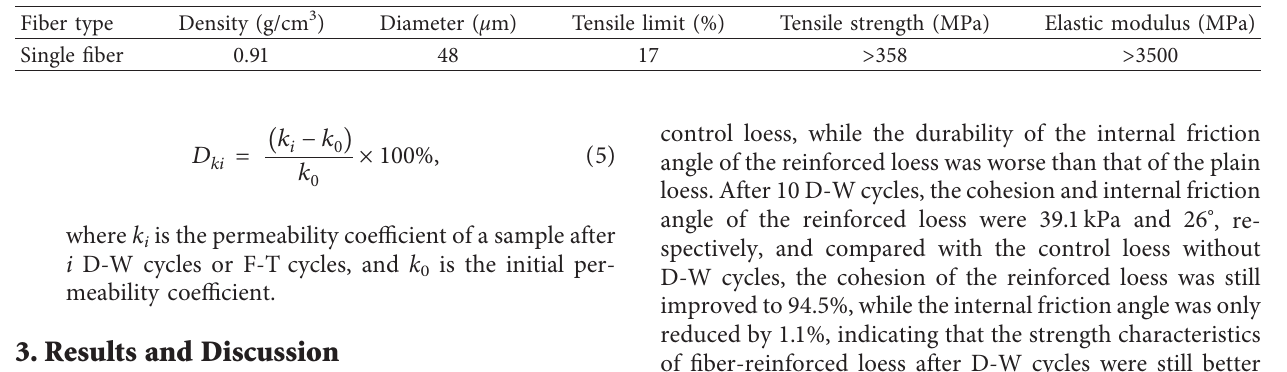
Table 1: Physical and mechanical properties of PP